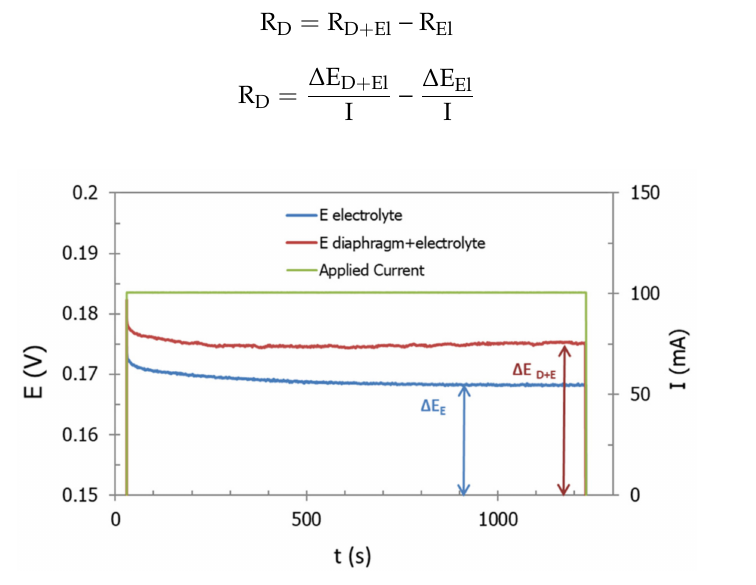
Figure 3. Example of trend in time of potential and current during a typical potentiometric measurement for resistance